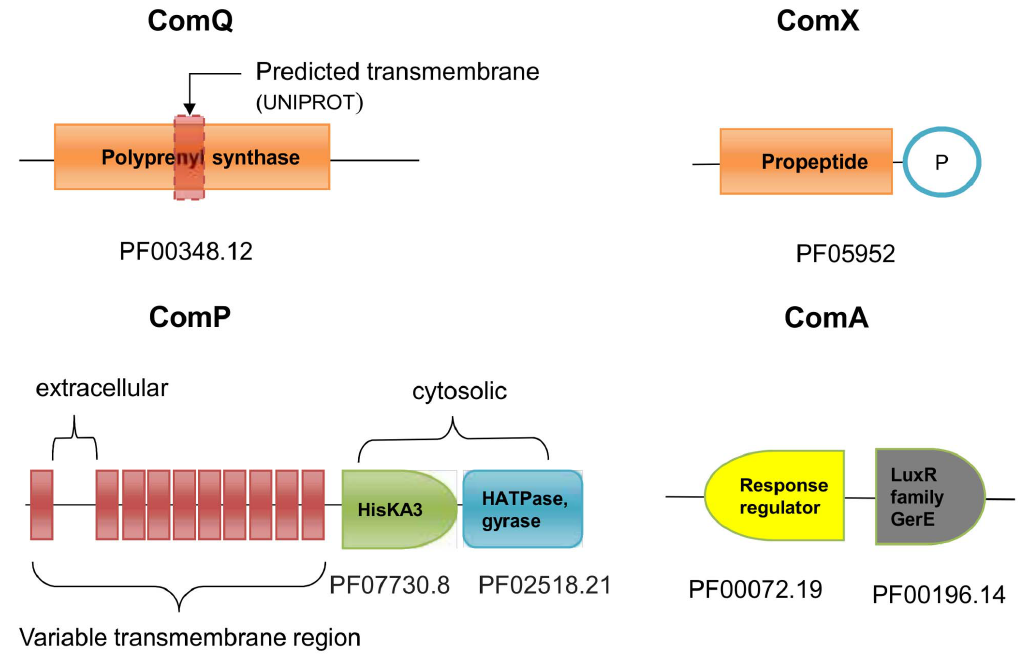
Figure 1. Domain structure of the Com proteins. The codes denote the PFAM (PF) domain identifiers.